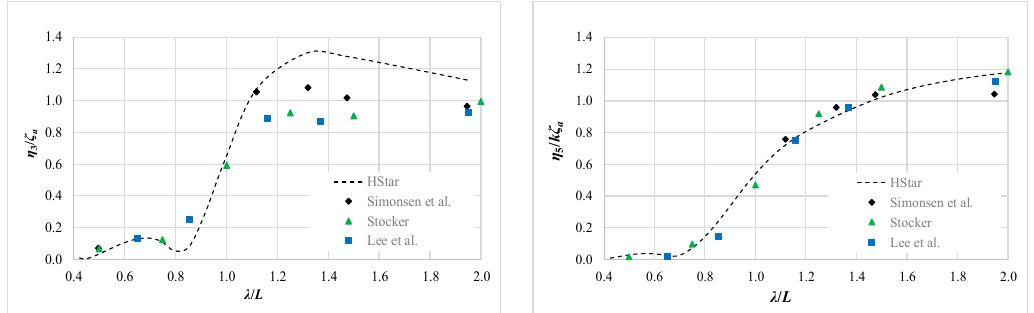
Figure 4. Comparison of the numerically obtained added resistance coefficient with available experimental data [36–38].